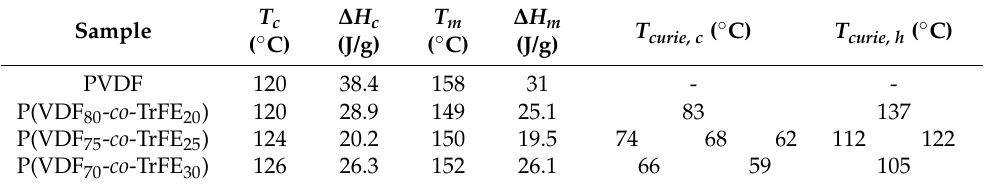
Table 1. Calorimetric data of all the samples obtained after the DSC heating and cooling scans at 20 ◦